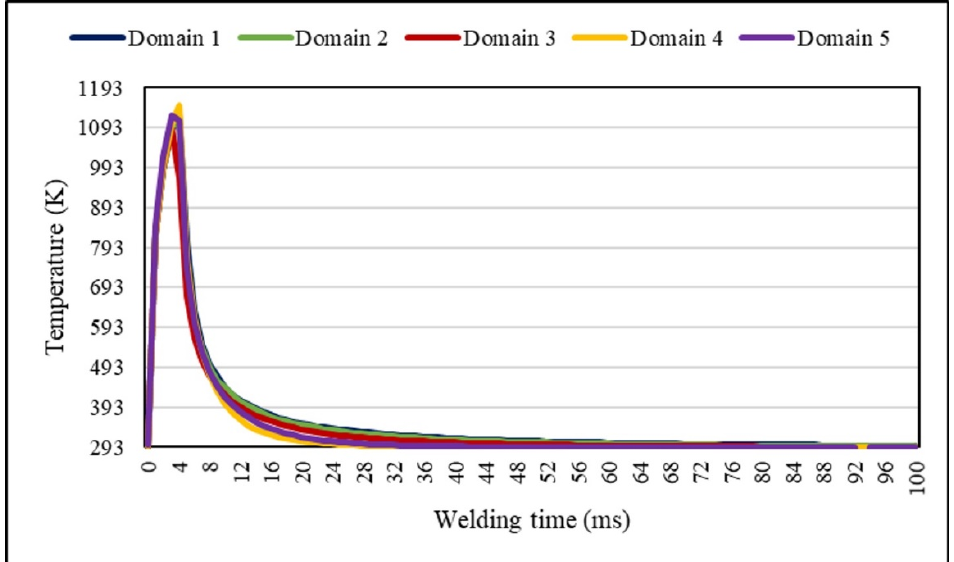
Figure 2. Domain size independence test.